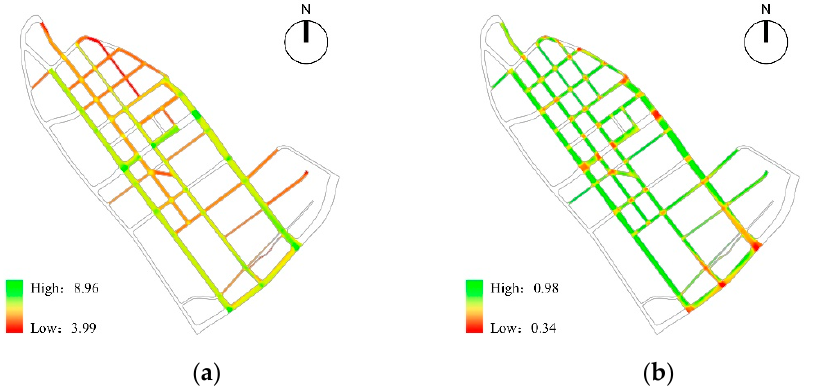
Figure 12. The analysis of pedestrian network safety: ( a ) Visual Integration; ( b ) Visual Clustering Coefficient.